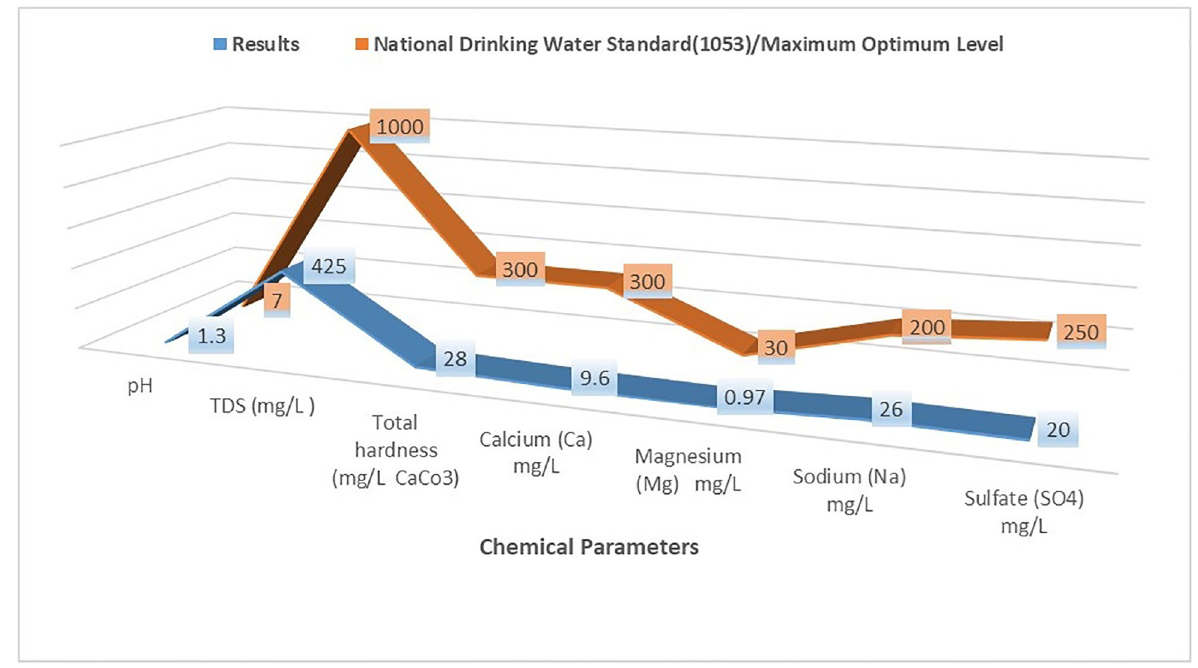
Fig 5. Comparing the quality of the bench-scale electrodialysis’ desalinated water to the national standards for drinking (Standard 1053).